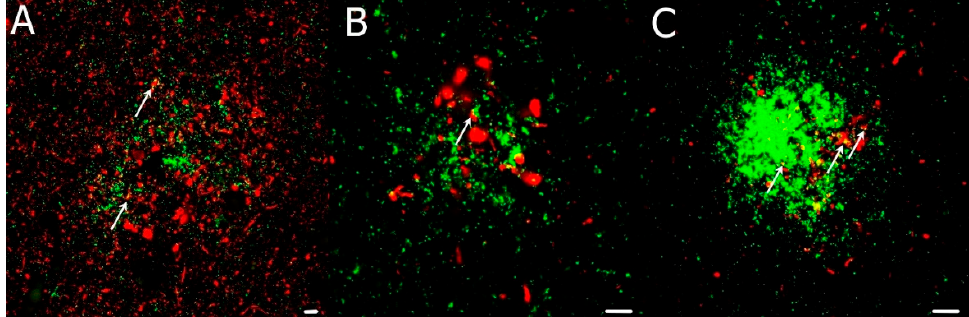
Figure 3. ( A – C ) Immunofluorescence illustrates h-tau-positive (red) dystrophic neurites colocalizing with PrP Sc (green) extracellular deposits in comorbid CJD/AD cases. Primary antibodies: PrP (rabbit recombinant monoclonal antibody) + AT8 (mouse monoclonal antibody). The secondary antibody was conjugated with either Alexa Fluor ® 488 (anti-rabbit IgG, green) or Alexa Fluor ® 568 (anti-mouse IgG, red). Scale bars indicate 10 µ m. Arrows indicate minor colocalization of AT8 with PrP. Images come from the hippocampal region (archicortical parts).